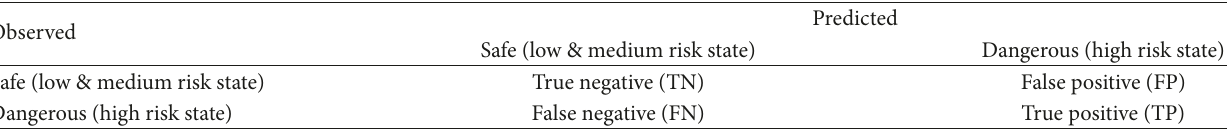
Table 3: Classification of prediction